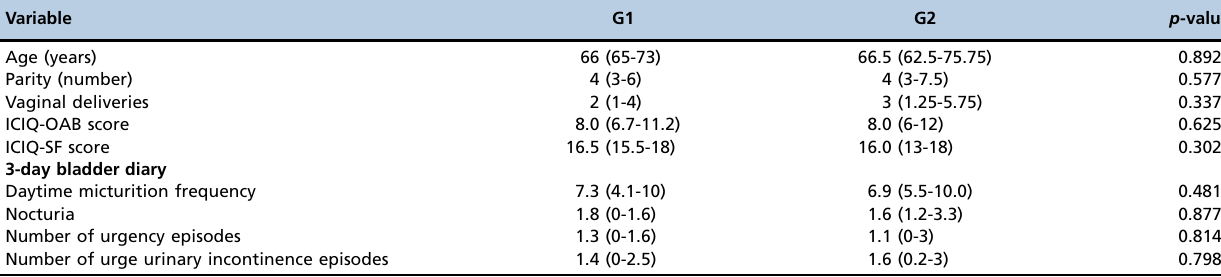
Table 1 - Demonstration of demographic and clinical data